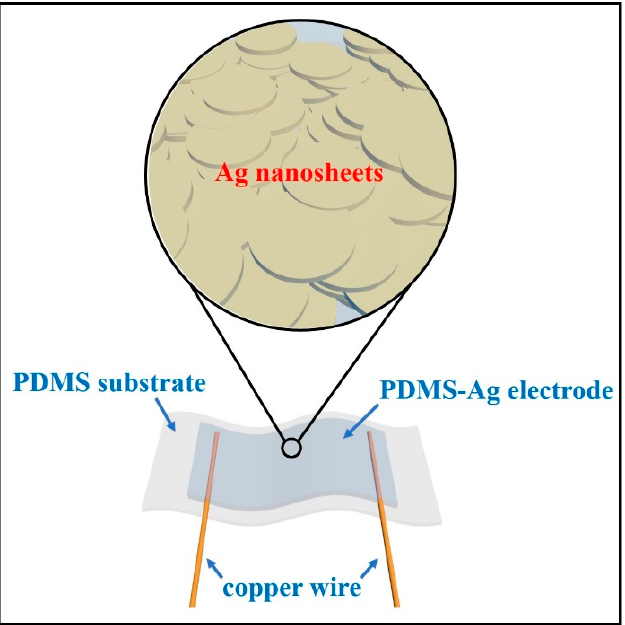
Figure 1. Schematic of the stretchable electrode based on PDMS-Ag nanosheets.